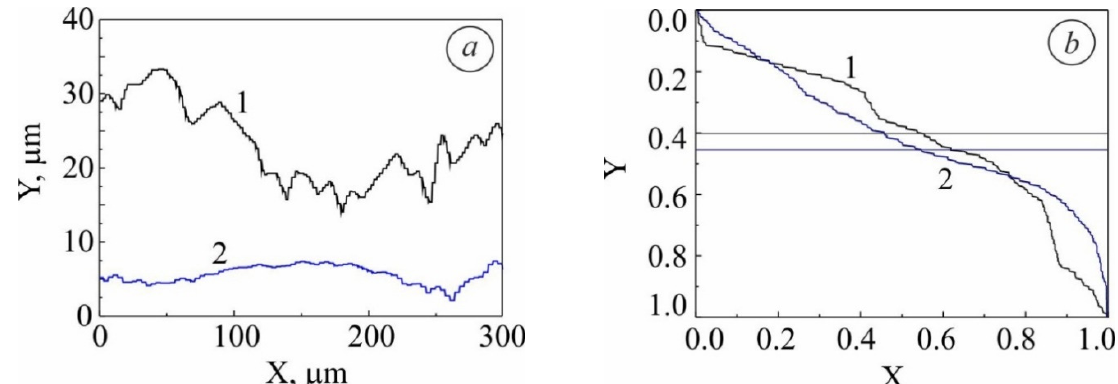
Figure 13. Cumulative wear mass loss for friction couples “AISI 304 steel (curves 1, 2)—counterbody (curves 1 / , 2 / )” at a contact pressure of 0.29 MPa (curves 1, 1 / ) and 0.42 MPa (curves 2, 2 / ) in the ( a ) initial state, and after laser alloying with a plaster of ( b ) 85Nb + 15% liquid glass, and ( c ) 15Fe + 30Ni + 20B + 10Si + 25% liquid glass.